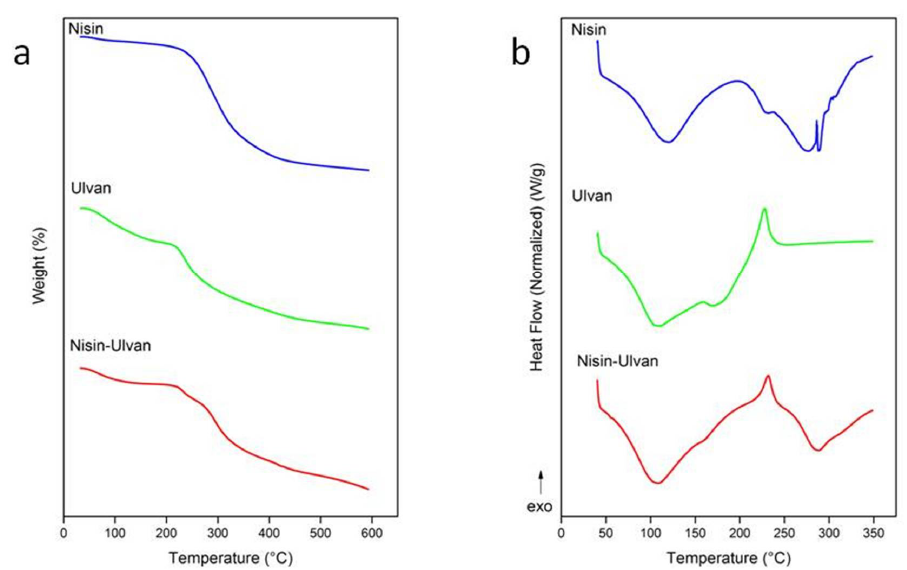
Figure 5. TGA ( a ) and DSC ( b ) thermograms of nisin, ulvan and nisin-loaded ulvan particles at pH 6.0.